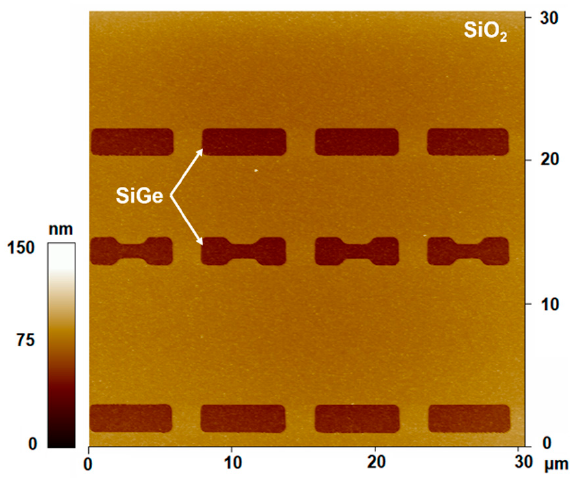
Figure 2. Atomic force microscopy (AFM) image (35 µ m × 35 µ m) of the p + -Si 0.73 Ge 0.27 film grown on the substrate openings of an SiO 2 masked Ge strain relaxed buffer (SRB) wafer. The root mean square (RMS) surface roughness is 2.4 nm. The growth is selective to SiO 2 . Table 1. p + -Si ~0.7 Ge ~0.3 layer properties. For the growth rate, all three methods are in agreement at ~45 nm/min. Similarly, Ge content as deducted from the three methods is ~30%.